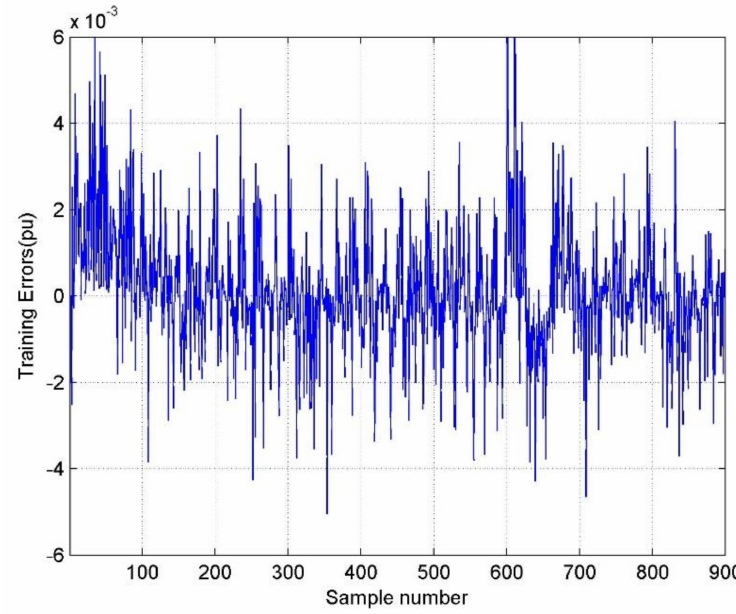
Figure 8. The training errors of modeling of